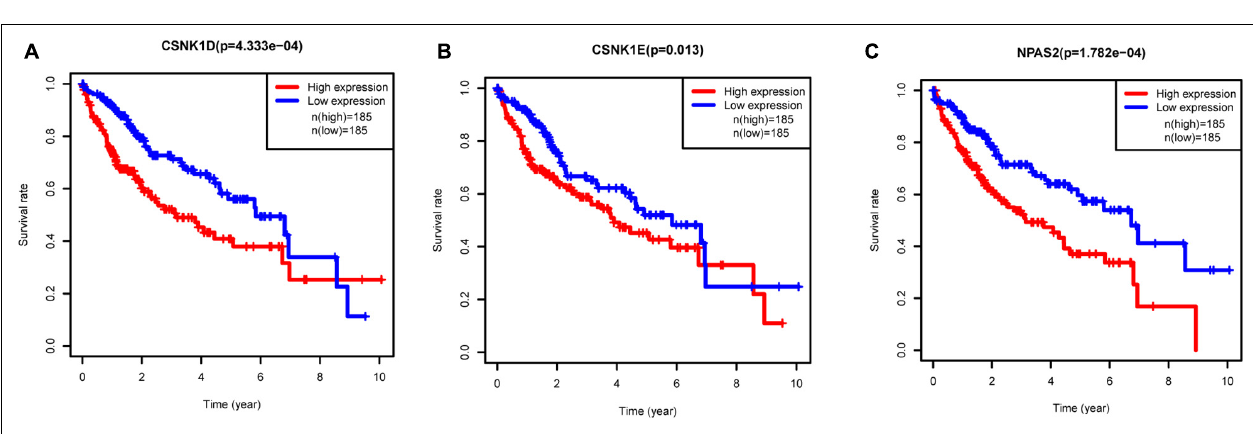
Frontiers in Genetics | www.frontiersin.org